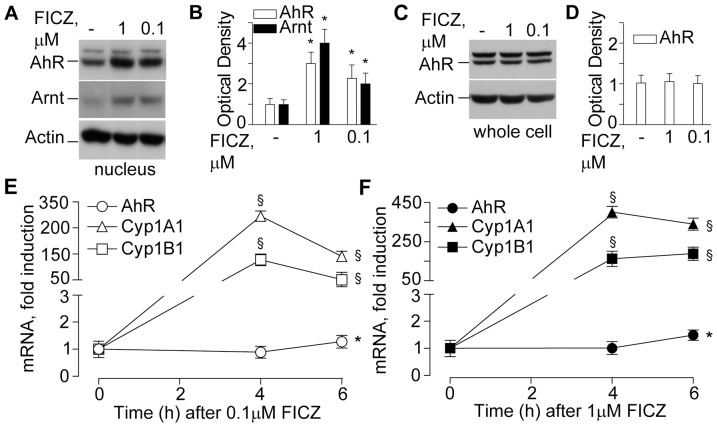
Effects of FICZ on metabolic system in NHEK.
A. Western blots of nuclear AhR and Arnt after 30 min exposure to 0.1 or 1.0 µM FICZ. B. Densitometry of western blot bands. C. Western blots of total whole cell AhR after 30 min exposure to 0.1 or 1.0 µM FICZ. D. Densitometry of western blot bands. *P<0.05 and §P<0.01 versus untreated controls (-). Time-course of AhR, CypA1 and Cyp1B1 levels following treatment with 0.1 µM FICZ (E) and 1 µM FICZ (F). *P<0.05 and §P<0.01 versus untreated controls (0 h). The results are representative of three independent experiments.